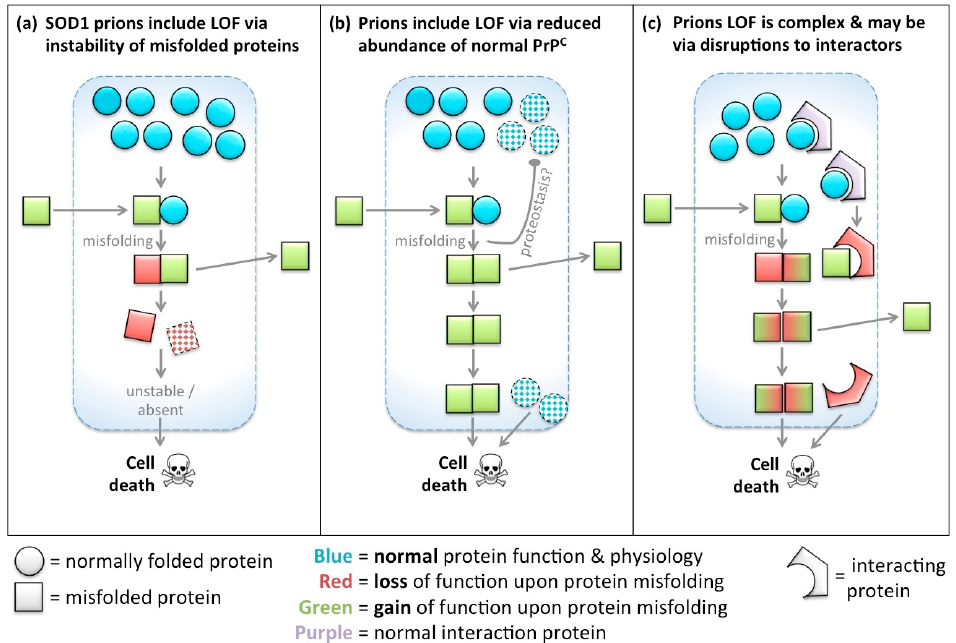
Figure 9. Loss or reduction in protein function appears to be required in prion-like disease. ( a )